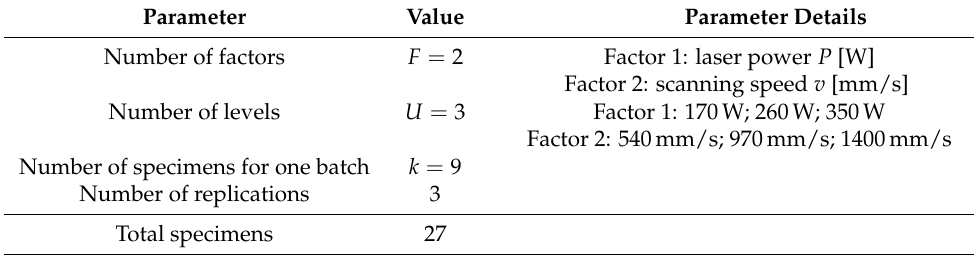
Table 4. DOE parameters definition.